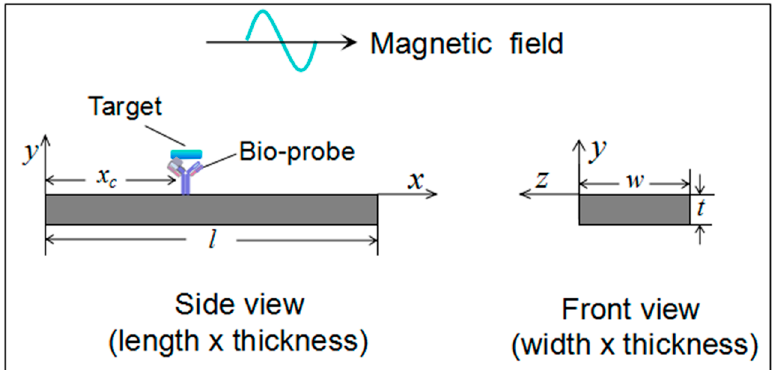
Figure 1. Schematic illustration of a target loaded magnetoelastic sensor vibrating in a liquid. l , w , and t are the total length, width and thickness of the sensor, respectively; and x c is x -coordinate of the target.